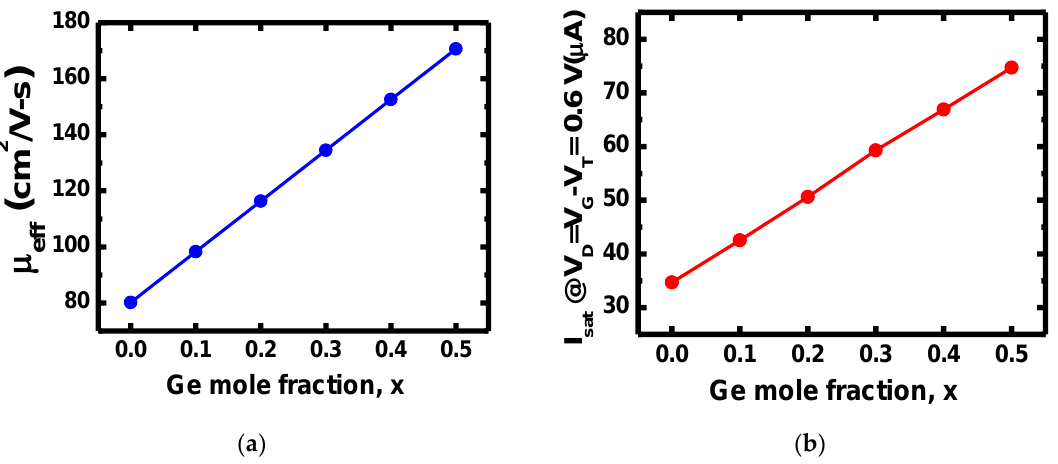
Figure 6. ( a ) extracted effective hole mobility of PMOS with varying Ge mole fractions. ( b ) I sat of PMOS with varying Ge mole fractions. I sat was extracted at V D = V G − V T = 0.6 V.